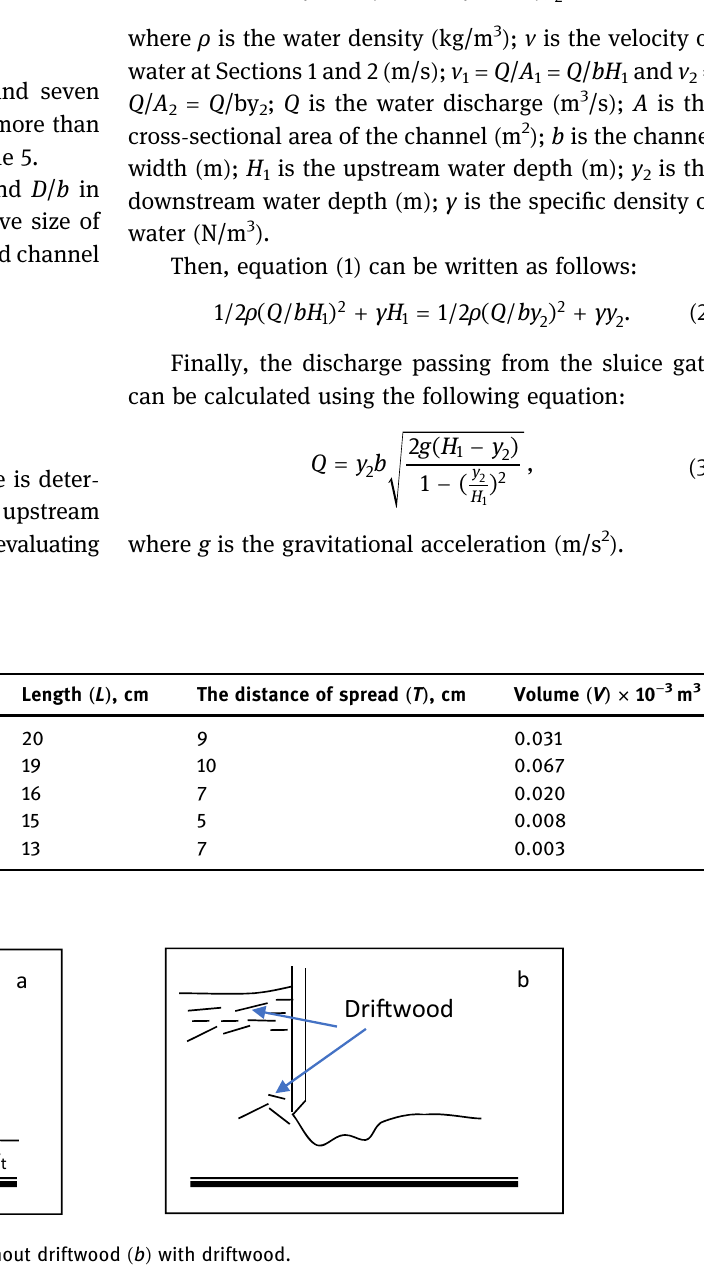
Figure 2: Driftwood used in experiments.